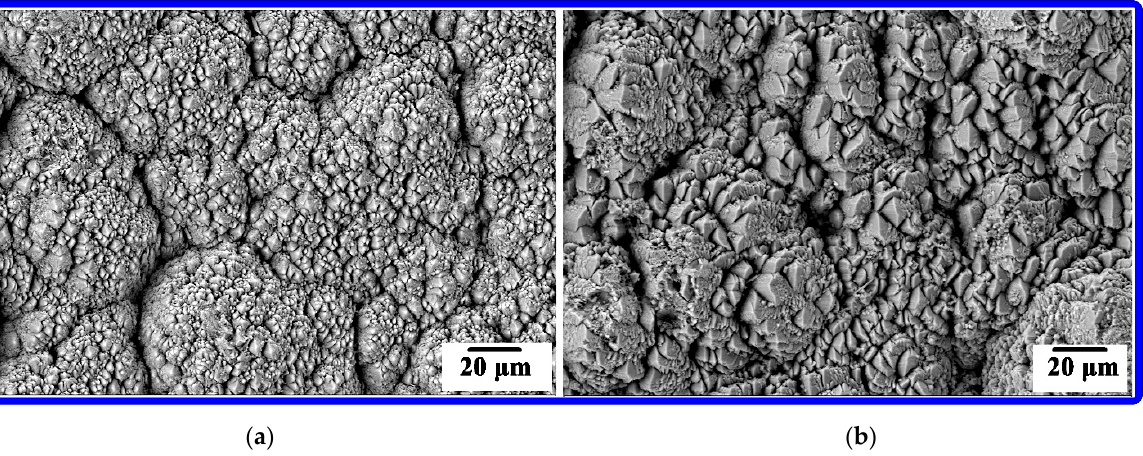
Figure 6. Surface morphology of YSZ coating system after ( a ) four and ( b ) eight corrosion cycles with NaCl.